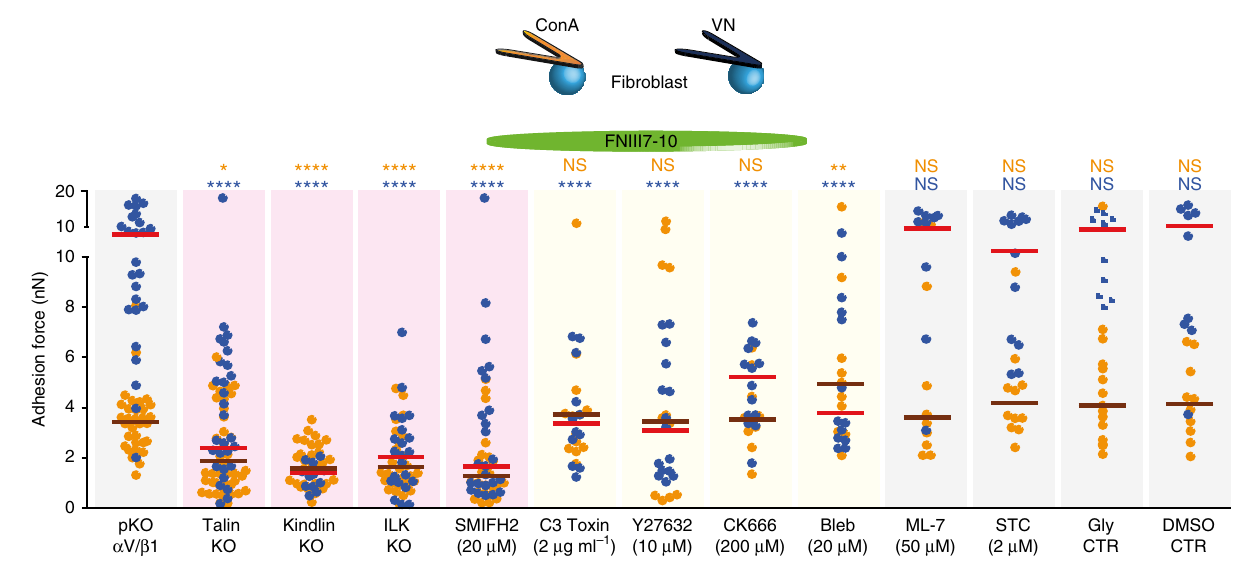
Figure 3 | Role of signalling molecules for the development of a 5 b 1 and a V-class integrin-mediated adhesion forces. Adhesion forces of knockout (KO) or pKO- a V/ b 1 fibroblasts to FNIII7-10 were determined both in the absence and presence of specific chemical inhibitors. pKO- a V/ b 1, talin KO, kindlin KO, ILK KO fibroblasts and pKO- a V/ b 1 fibroblasts treated with chemical inhibitors were attached to either ConA (yellow)- or VN (blue)-coated cantilevers. If not stated pKO- a V/ b 1 fibroblasts were used for experiments. Fibroblasts were adhered to FNIII7-10-coated substrates for 120s. Chemical inhibitors were added at indicated concentrations to pKO- a V/ b 1 fibroblasts starting 30min before experiments, with the exception of C3 toxin, which was added 3h before. S-trityl- L -cysteine (STC), glycerol (Gly) and DMSO were used as negative controls (CTR) to measure the adhesion of pKO- a V/ b 1 fibroblasts. For VN-stimulating fibroblasts, cantilevers were coated by 5 m gml –1 VN diluted in ConA. Dots show adhesion forces of single fibroblasts ( n Z 10 for each condition) and red bars their median. Statistical significance was determined to compare unperturbed and perturbed adhesion for each (non-stimulated and